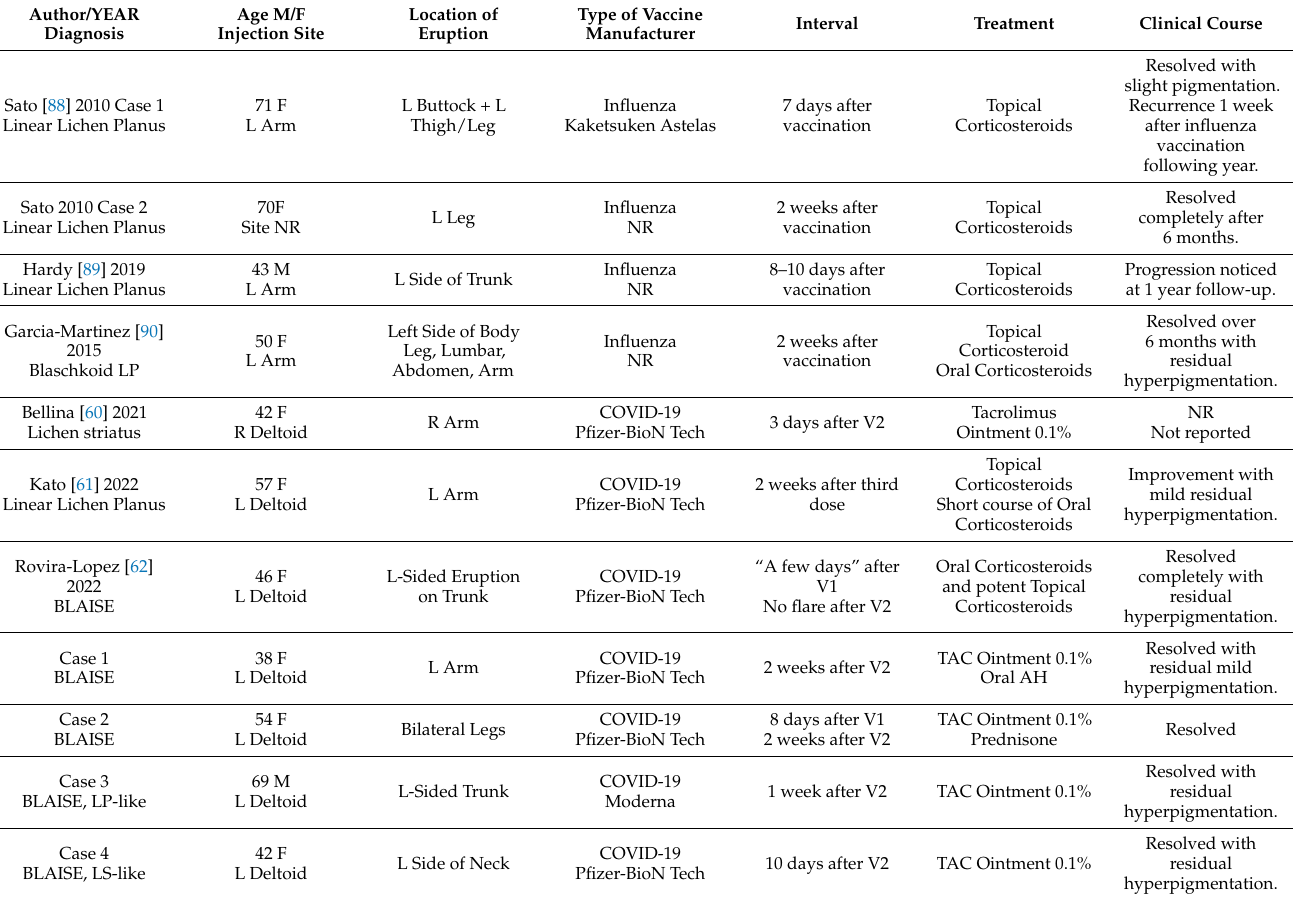
Table 5. Vaccine-Induced Lichenoid Eruptions with a Blaschkoid